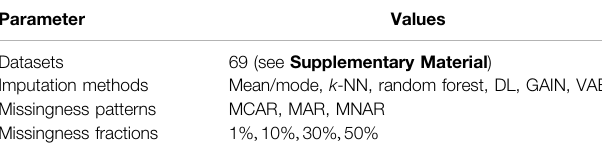
TABLE 6 | Overview of our experimental settings. We focus on covering an extensive range of the dimensions described in Section 2 . In total, there are 4 , 968 experiments, which we repeat three times to report the mean imputation/ downstream